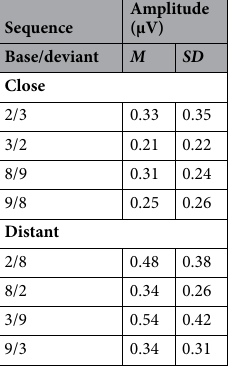
Table 1. Discrimination response amplitude (mean and corresponding standard deviation) for each individual sequence. Note that the amplitude values reported here result from a noise correction at the individual sequence